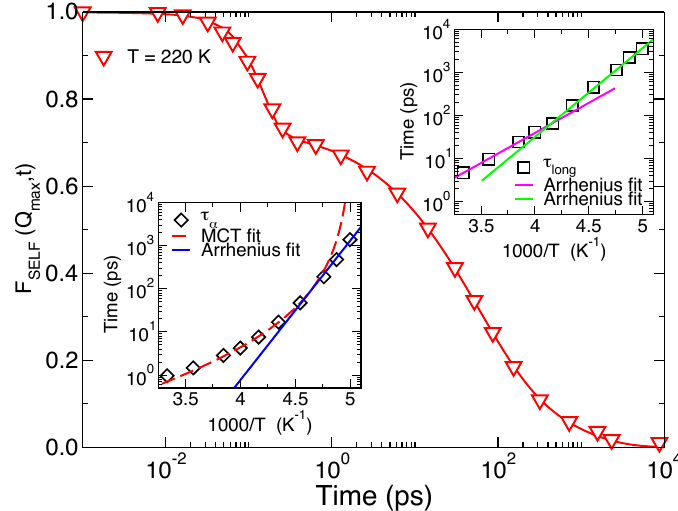
Figure 2. Main panel: F SELF ( Q max , t ) of lysozyme hydration water oxygens calculated at T = 220 K. The continuous line is the fit to Equation (2). Bottom inset: behaviour of the τ α as a function of the temperature. At high temperature it fits the Mode Coupling Theory (MCT) (fragile) behaviour (dashed line), while at low temperature it fits the Arrhenius (strong) behaviour (continuous line). The fragile to strong crossover is observed at T = 215 K. Upper inset: behaviour of the τ long as a function of the temperature. It fits to two Arrhenius laws with different activation energies at high and low temperature. The strong to strong crossover is observed at T = 240 K where the lysozyme shows its protein dynamical transition (PDT) (not shown